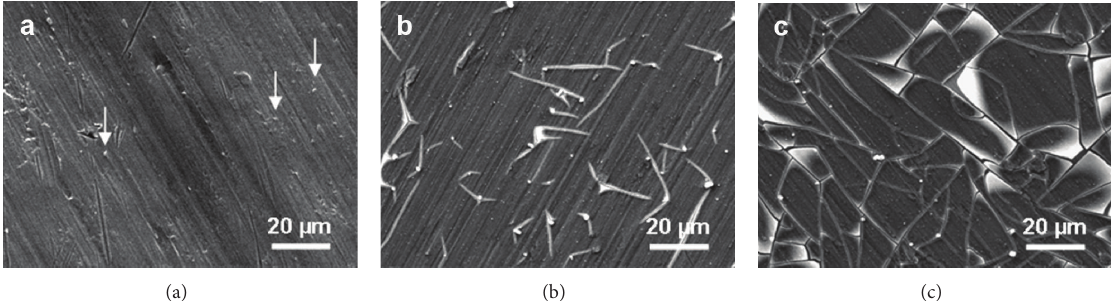
Figure 9: SEM images of the TS + 22nm surface after immersion in SBF solution for (a) 12h, (b) 72 h, and (c) 1 week. Distinct precipitates were observed after 12h (marked with